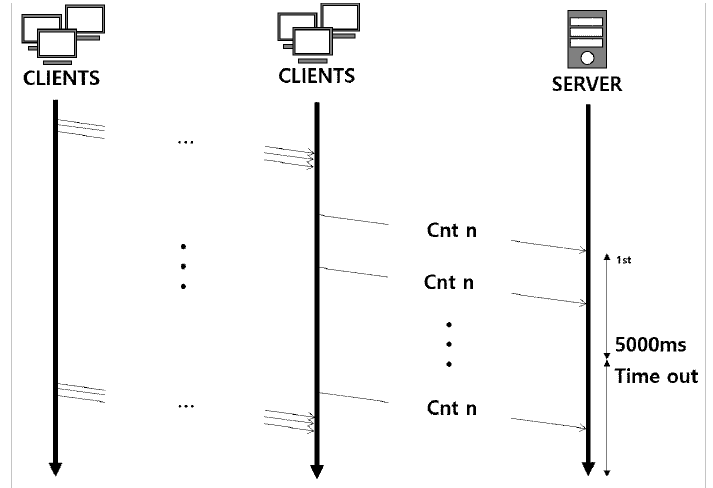
Figure 6. Diagram of the timeout for the client data to be received by the server.